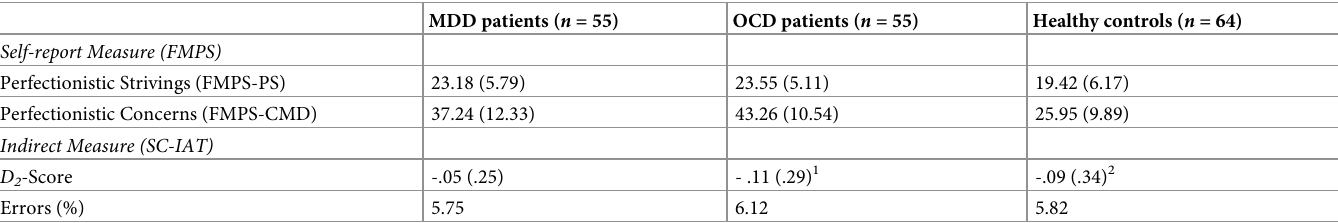
Table 4. Perfectionism data: Mean (standard